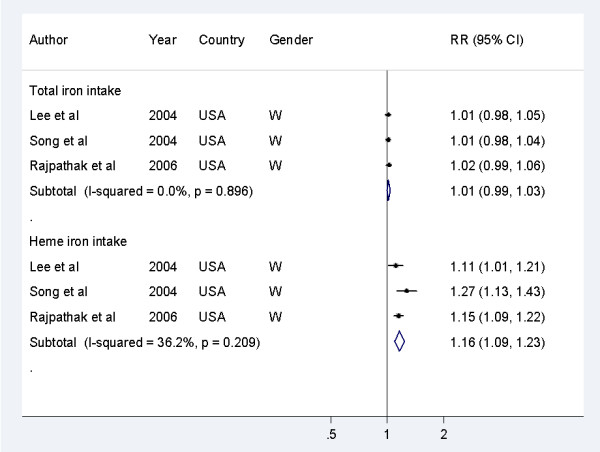
Dose-response analyses of dietary intakes of total iron and heme iron in relation to risk of type 2 diabetes mellitus (T2DM) in the included studies. The risk estimate of dietary total iron intake for T2DM risk in the Iowa Women's Health Study (Lee et al [24])) was not directly reported, and thus this was pooled from the results of dietary non-heme iron intake and heme iron intake in this study. W, women.